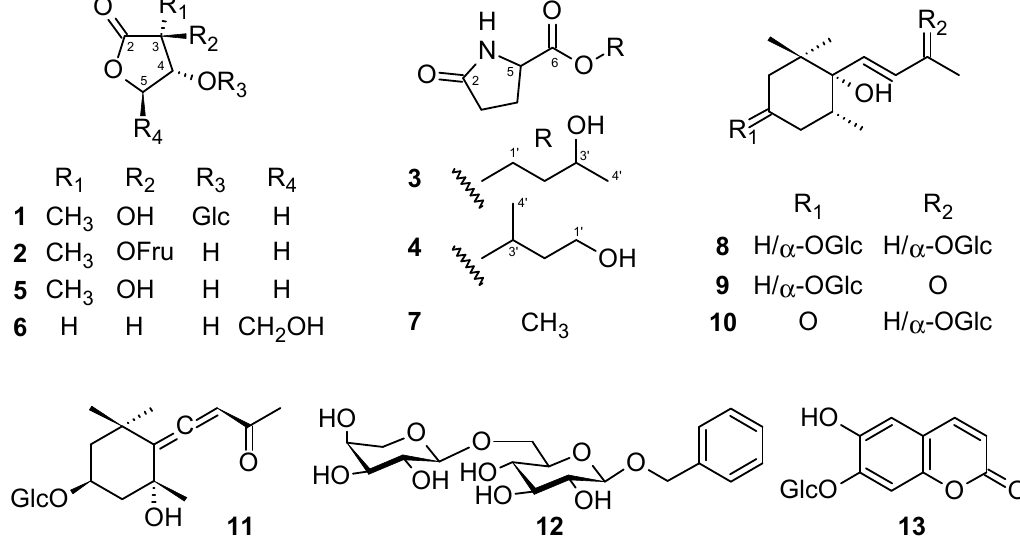
Figure 1. Structures of compounds 1 – 13.